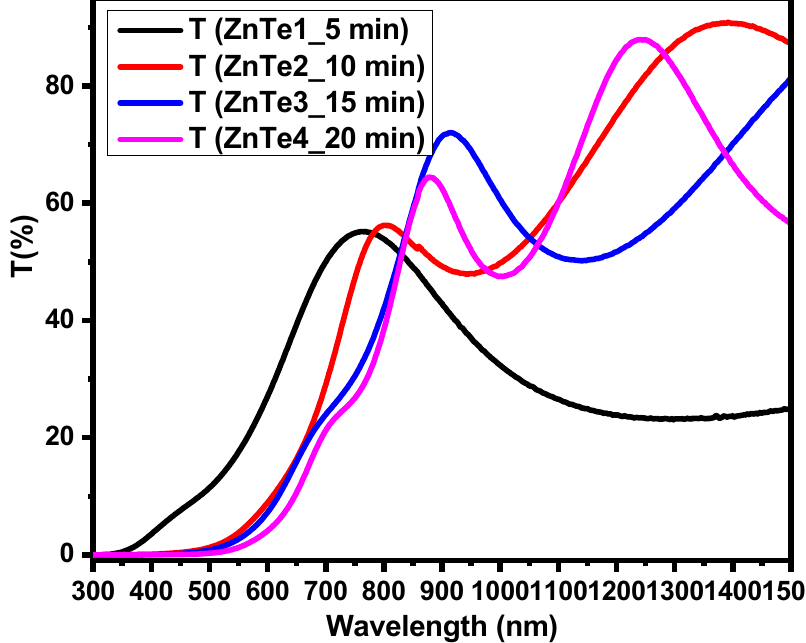
Figure 12. UV-Vis transmission spectroscopy spectra of ZnTe thin films with different thicknesses.